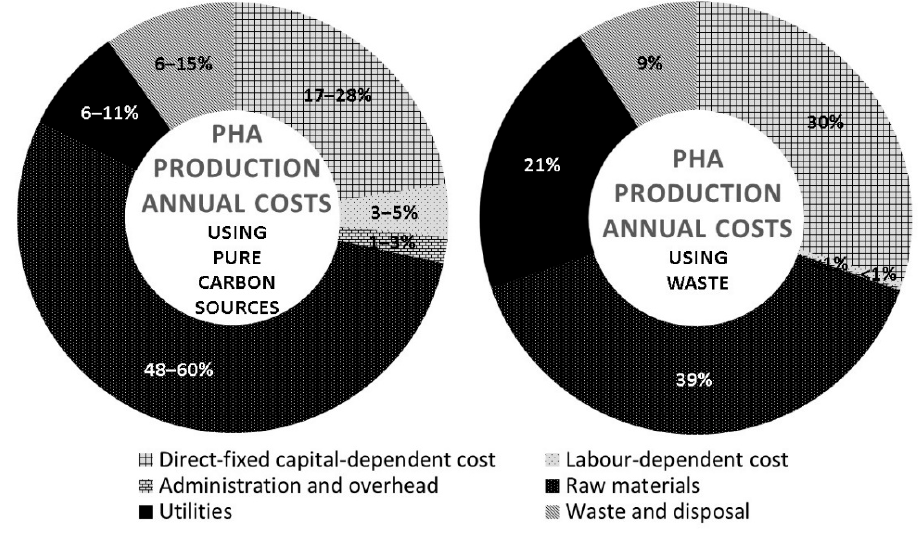
Figure 3. Techno-economic analysis on PHA production annual costs using pure carbon sources and wastes [93,95].